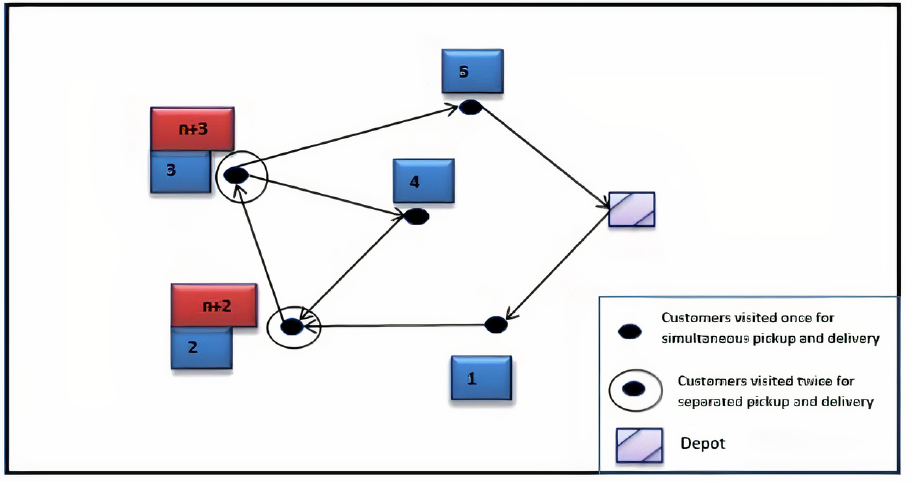
Figure 3. Overview of the flexible vehicle routing problem with pickup and delivery (VRPPD): MILP